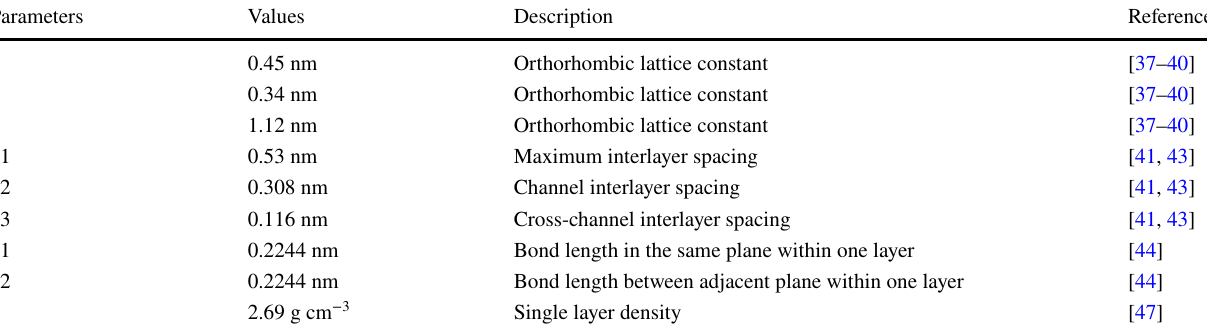
Table 1 Detailed parameters of black phosphorus including lattice constant, interlayer distance, bond length, and density Parameters Values